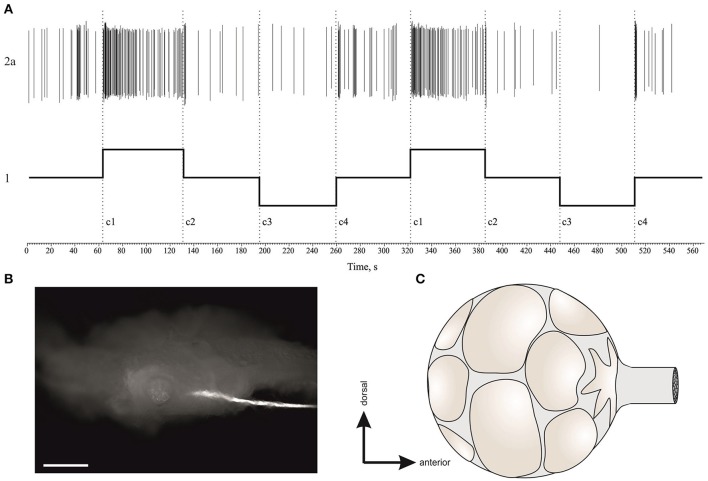
(A), Example of a single unit in statocyst activity responding to head down (c1) tilt only. This single unit presumably represents the activity of the unpaired statoreceptor at the anterior pole of statocyst (star-shaped). (B), The position of right statocyst on dorsal surface of right pedal ganglion, n.vestibularis are backfilled with carboxyfluorescein, calibration bar is 100 μm. (C), Schematic drawing of statoreceptors' position in the statocyst, and the unpaired cell at anterior pole is star-shaped (based on data Gorgiladze et al., 2013).